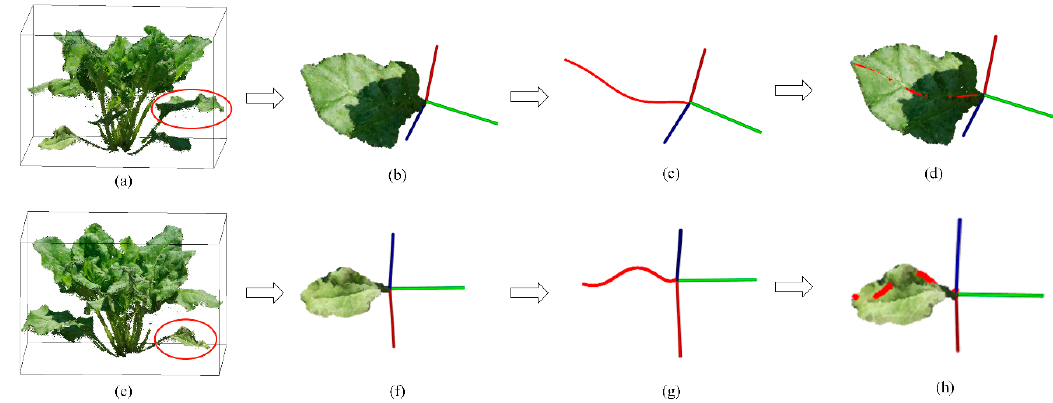
Figure 11. Leaf blade length extraction for common leaf ( a – d ) and twisted leaf ( e – h ). ( a , e ) Targeted leaf on the plant; ( b , f ) The display of leaf blade without petiole; ( c , g ) Extracted curves of midrib; ( d , h ) The display of extracted curves on leaves.